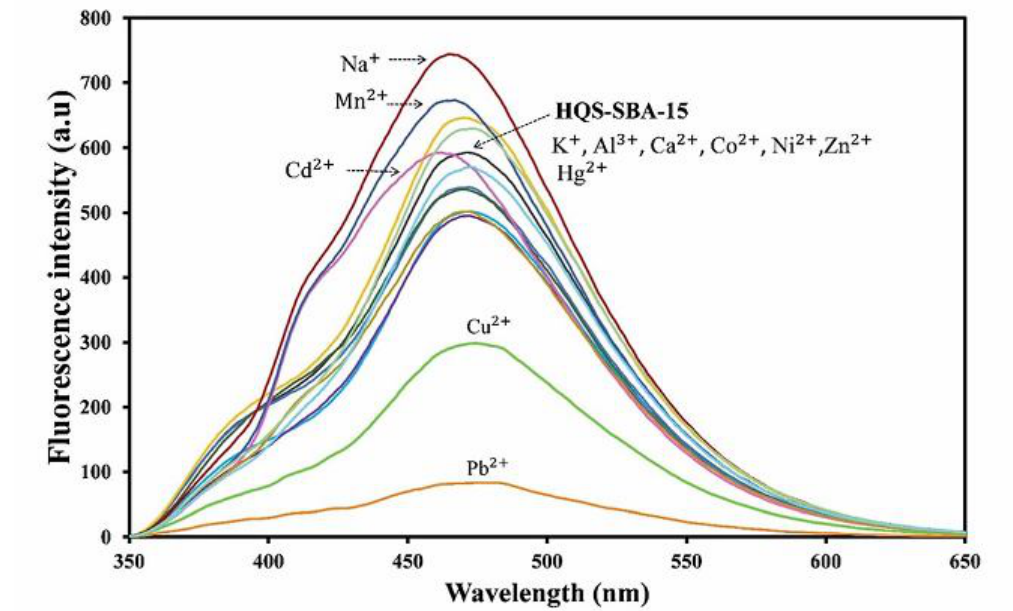
Fig. 9. Fluorescence spectra of the aqueous suspended HQS-SBA-15 in the presence of different metal cations